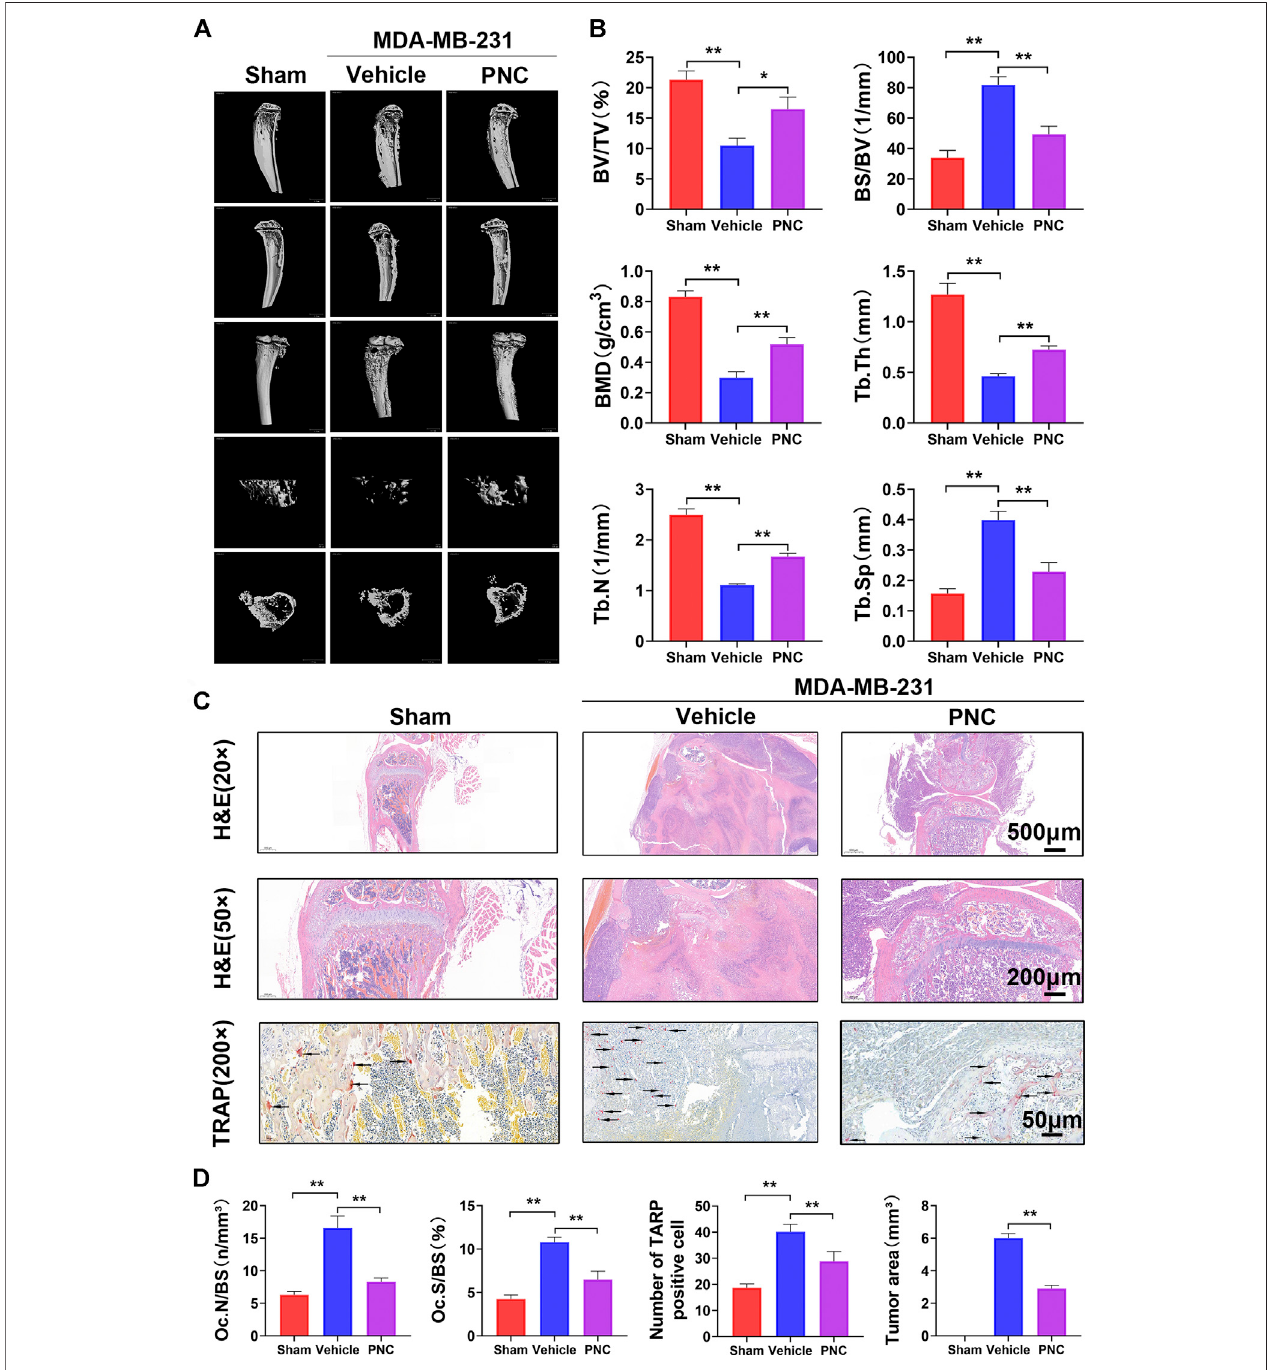
FIGURE6| PNCreducedosteolysisandbonedestructioninMDA-MB-231cell-bearingmice. (A) Illustrative3Dcomputerreconstructionofthebonenearthekneejointby micro-CTscanningexhibited extensivetrabecular/cancellousbonelossofthetumor-bearingmiceinthevehiclegroup.Treatmentwith PNCreducedbonelossin tumor-bearing mice. (B) Quanti fi cationoftheboneparametersdemonstratedthatMDA-MB-231tumorcellsinducedbonelosswithsigni fi cantlydecreasedTb.N,BV/TV,BMD,andTb.Thvalues aswellasincreasedBS/BVandTb.Sp.PNCrescuedtheseboneparameters( n (cid:1) 5). (C)